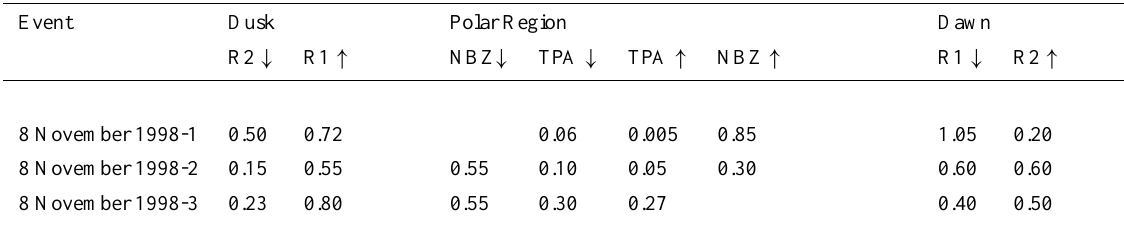
Table 1. Modelled field-aligned current values (MA) for 8 November 1998. Event Dusk Polar Region